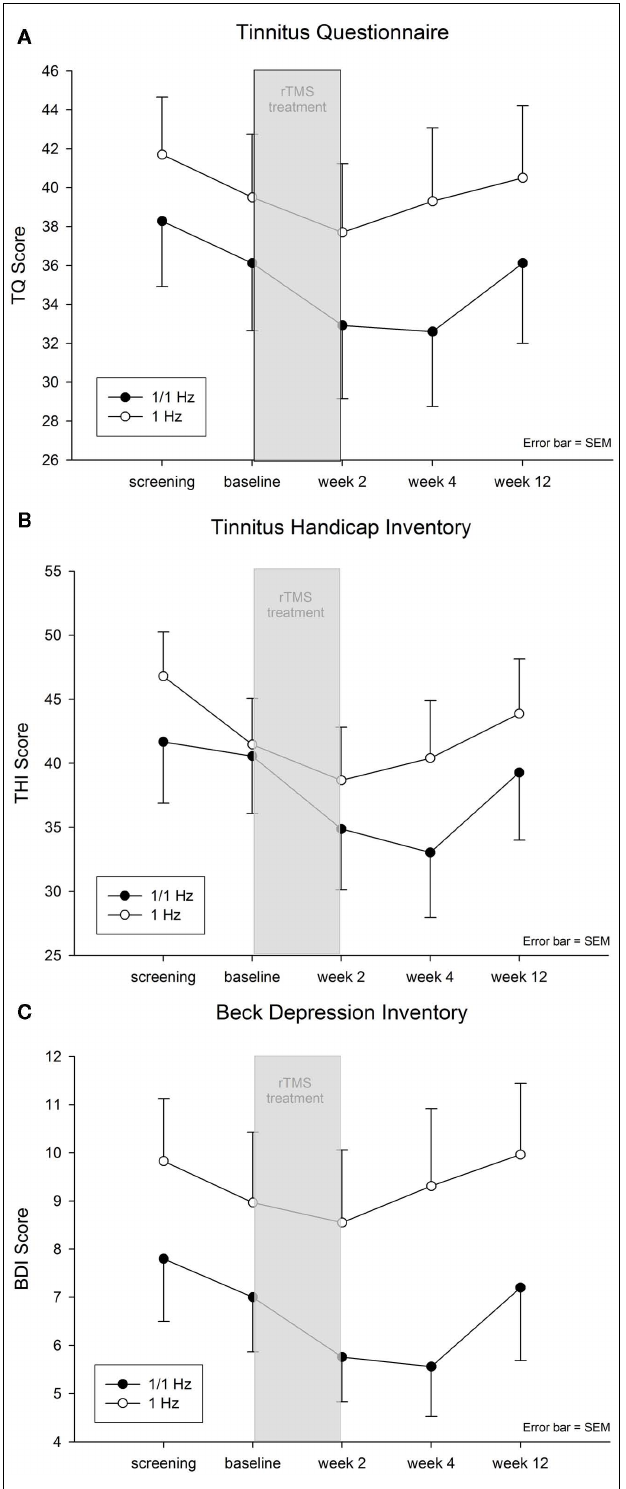
FIGURE 1 | (A) Tinnitus Questionnaire Score (TQ; mean ± SEM), (B) Tinnitus Handicap Inventory (THI; mean ± SEM), and (C) Beck Depression Inventory (BDI; mean ±